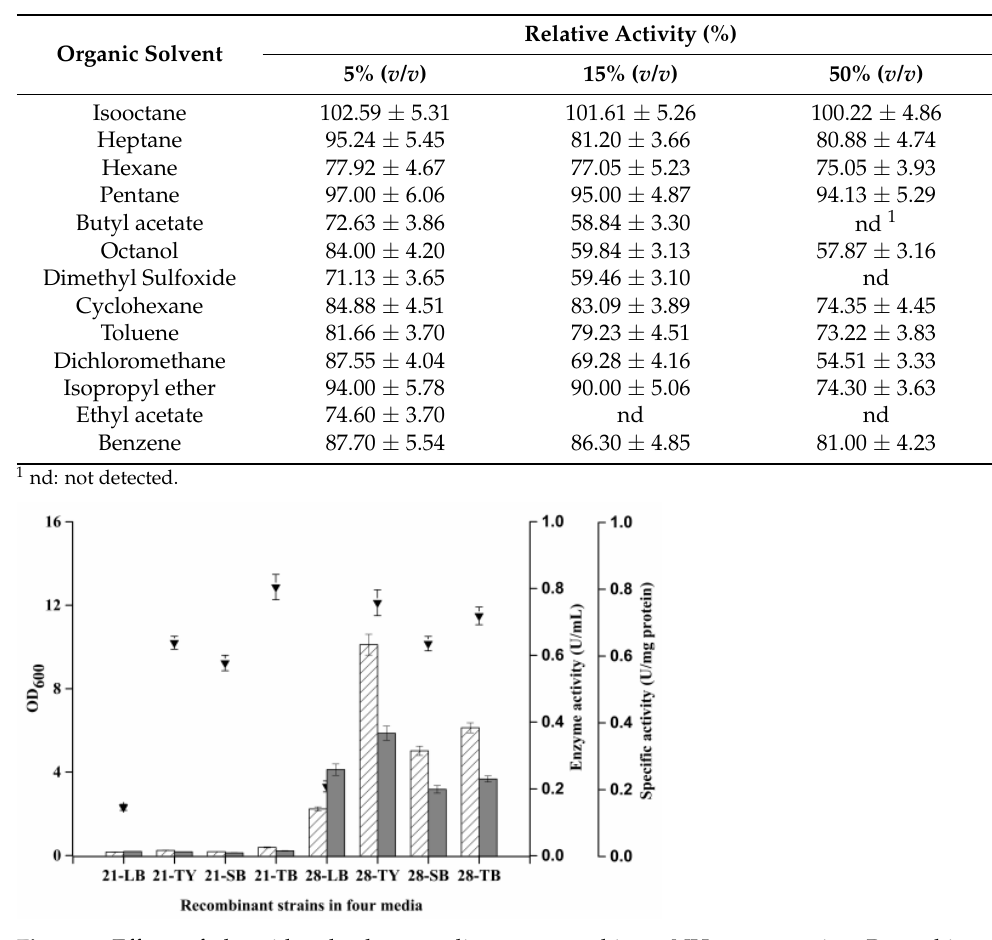
Figure 5. Effects of plasmid and culture medium on recombinant NHase expression. Recombinant E. coli strain BL21(DE3)/pET-28a + NHase and E. coli BL21(DE3)/pET-21a + NHase were cultivated in LB, TB, TY and SB media. Induction temperature (20 °C), inducer (0.1 mM IPTG) and 0.5 mM Co 2+ .